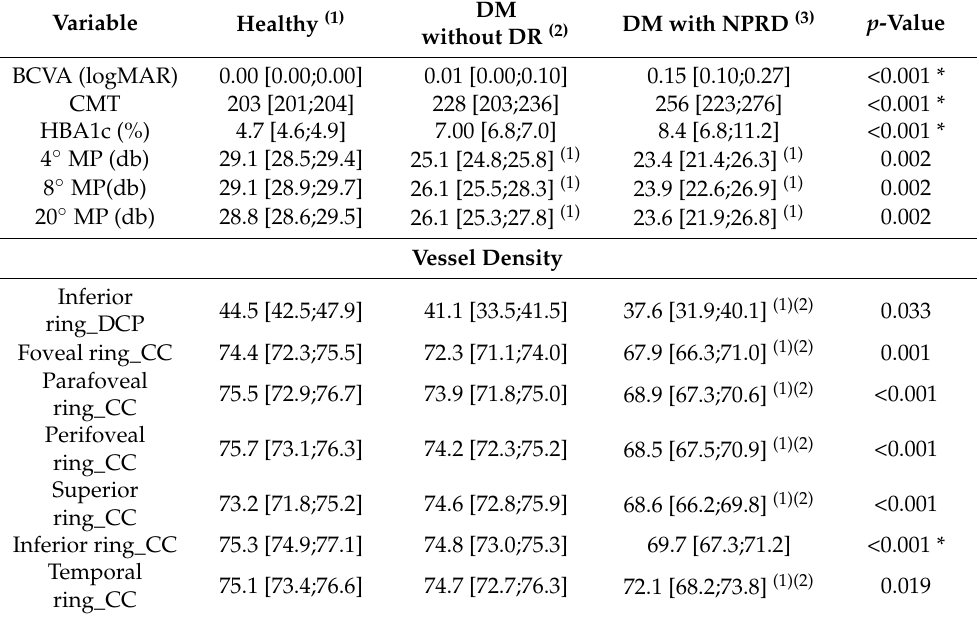
Table 2. Anatomical/perfusion and functional parameters. All values are expressed as median (1st quartile; 3rd quartile). p -value results from the nonparametric test for independent samples. For analyzing the specific sample pairs for stochastic dominance, Dunn’s test was used. To show the pairwise differences, we assigned a number to each group: healthy = (1), DM without DR = (2), DM with NPRD = (3). The star (*) indicates that all groups are different from each other; then, if not, then the number of the group from which it differs is